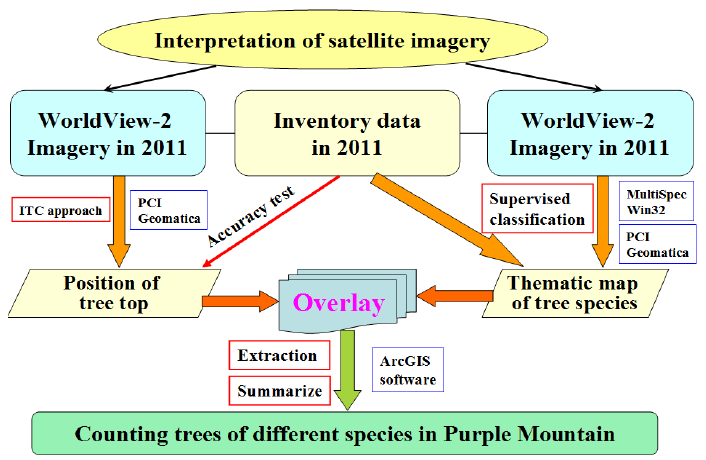
Figure 2. Research flow chart. ITC, individual tree